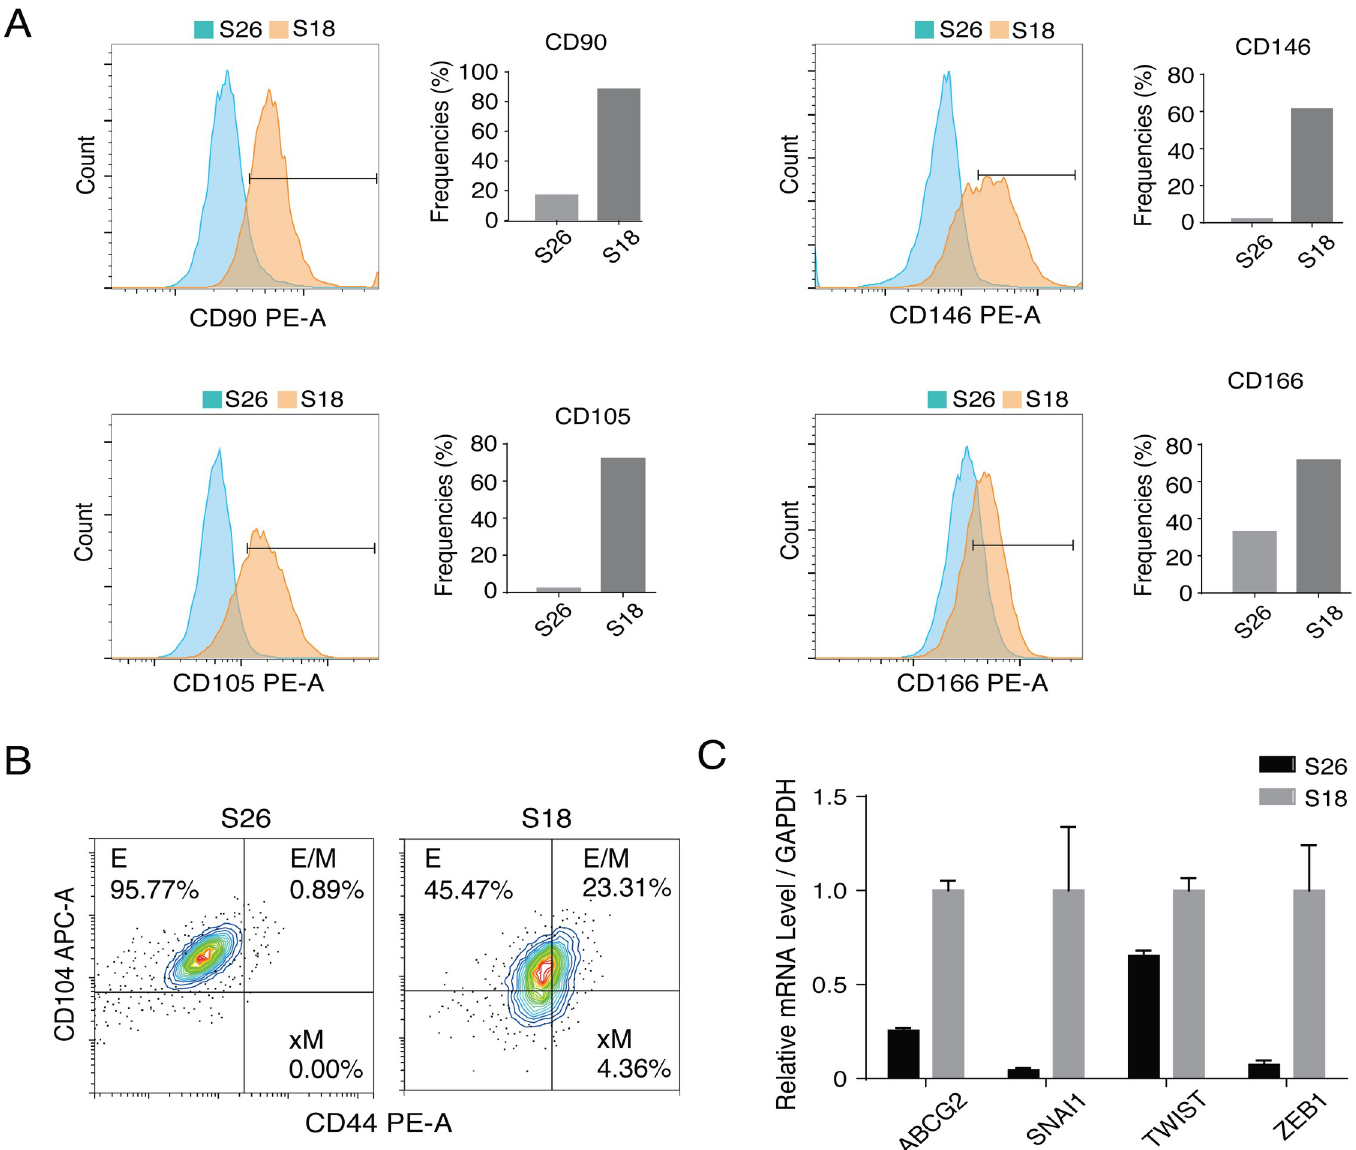
Fig 2. Epithelial-to-mesenchymal states of S18 and S26 clones of CNE-2 cells. ( A) Flow cytometry histograms of EMT-associated markers CD90, CD146, CD105, and CD166 in S26 and S18 cells. ( B) FACS profiles for CD44 and CD104 of S26 and S18 cells. ( C) Relative mRNA expression level vs. GAPDH of EMT transcription factors (EMT-TFs) in S26 and S18 cells (Mean+/- SD of three biological